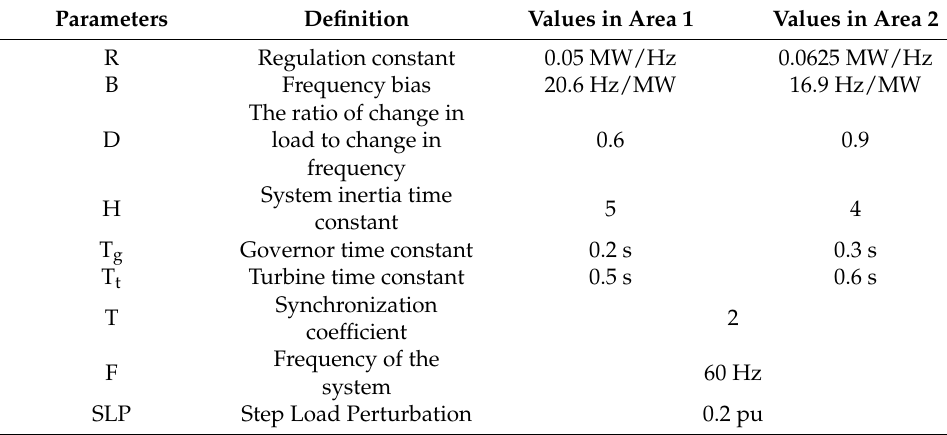
Table 1. The parameter of the testbed system